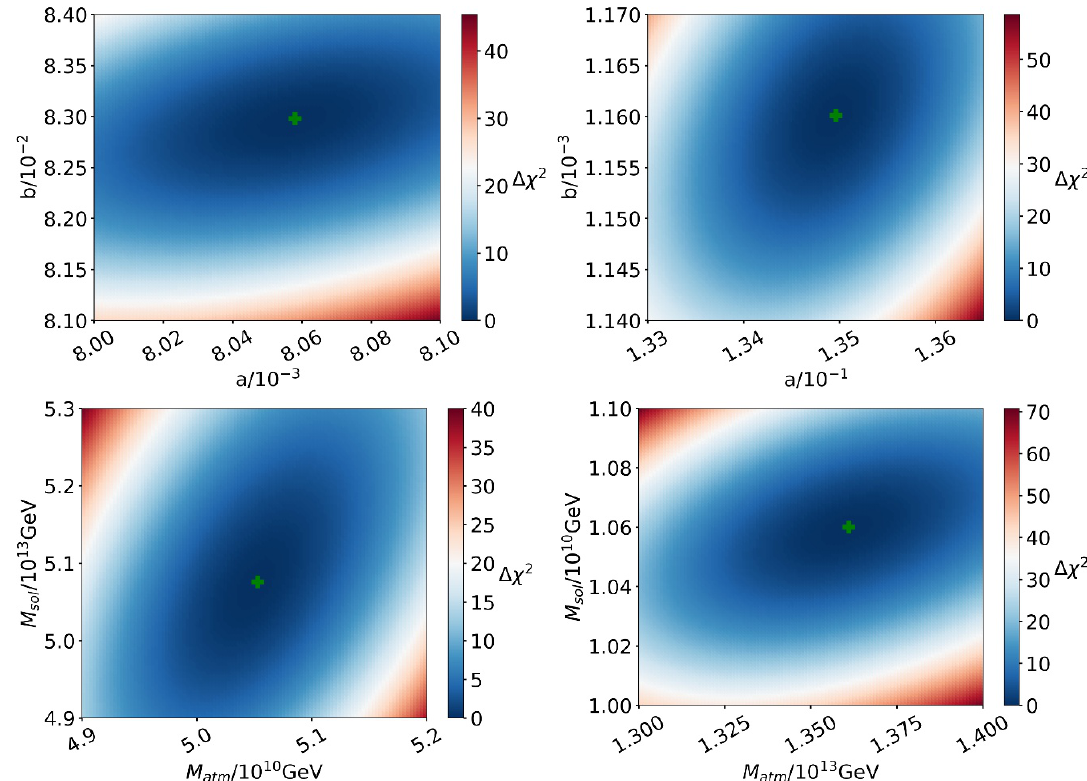
Figure 4 . Perturbations around Case A2 benchmark point shown on the left, those for Case D2 on the right. In each case, two parameters are varied at a time while the other two are kept (cid:12)xed. Di(cid:11)erently coloured circles represent approximate 1, 2 and 3 sigma deviations from the best (cid:12)t in each parameter, and the green cross marks the benchmark